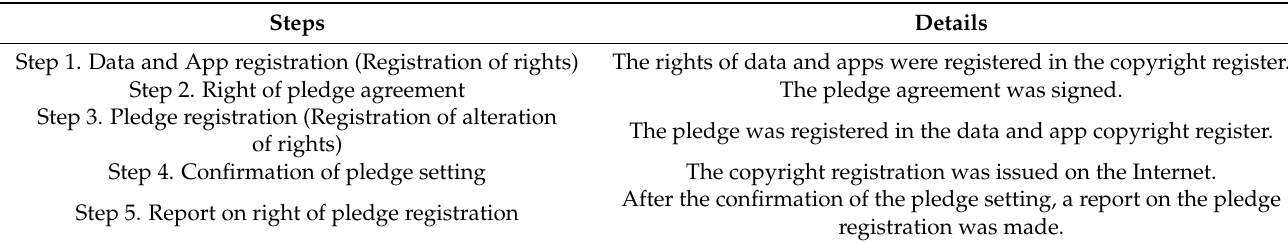
Table 5. Process to set collateral.